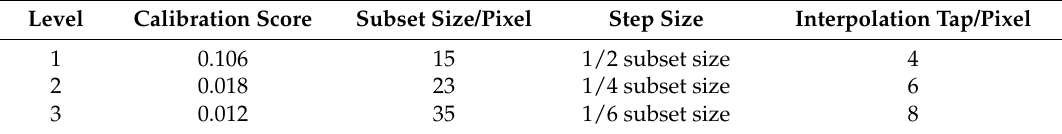
Table 1. Four factors and three levels of each factor in the orthogonal experiment.